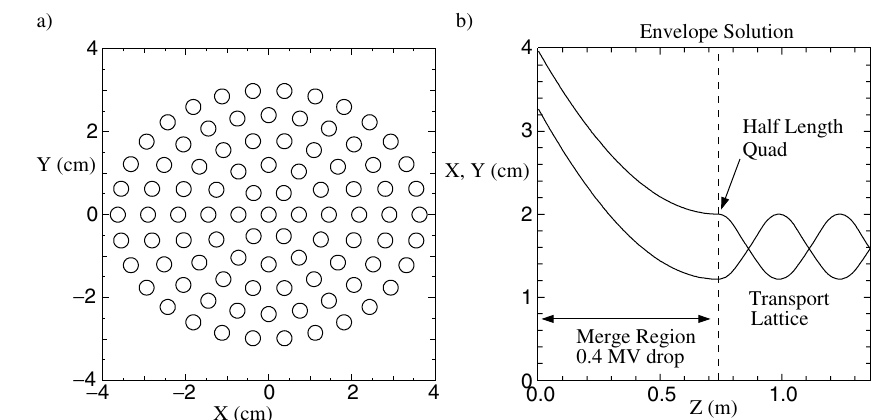
FIG. 2. The configuration of apertures at the last accelerating plate. Each aperture has a radius of 2 mm. The elliptical arrangement allows the combined beam to be exactly matched into the quadrupole transport